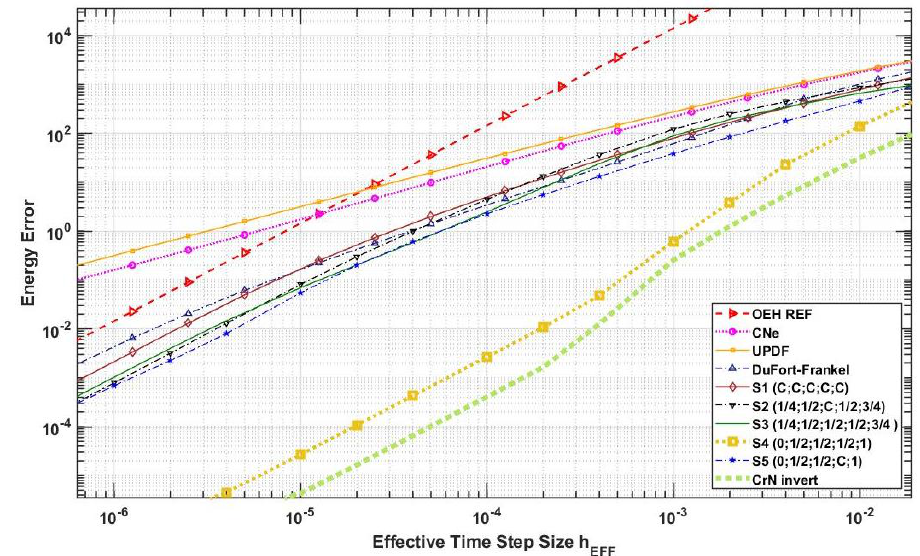
Figure 6. Energy errors as a function of the time step size for the second (very stiff) system, in the case of the original OEH method (OEH REF), the original one-stage CNe, UPFD and the Dufort-Frankel methods, the new algorithms S1–S5, and the Crank–Nicholson method.